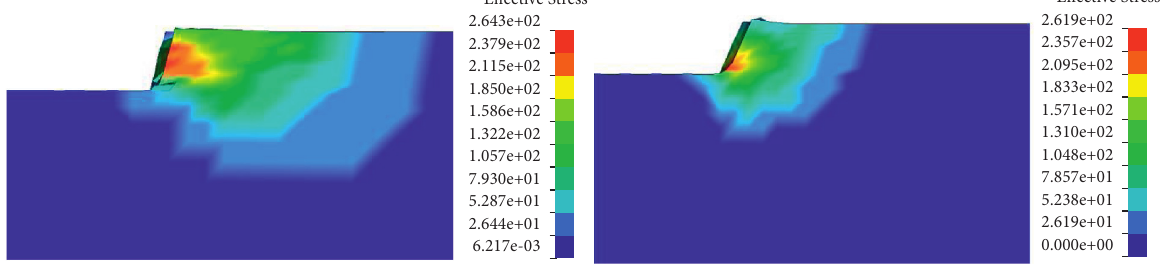
Figure 3: Equivalent stress cloud.